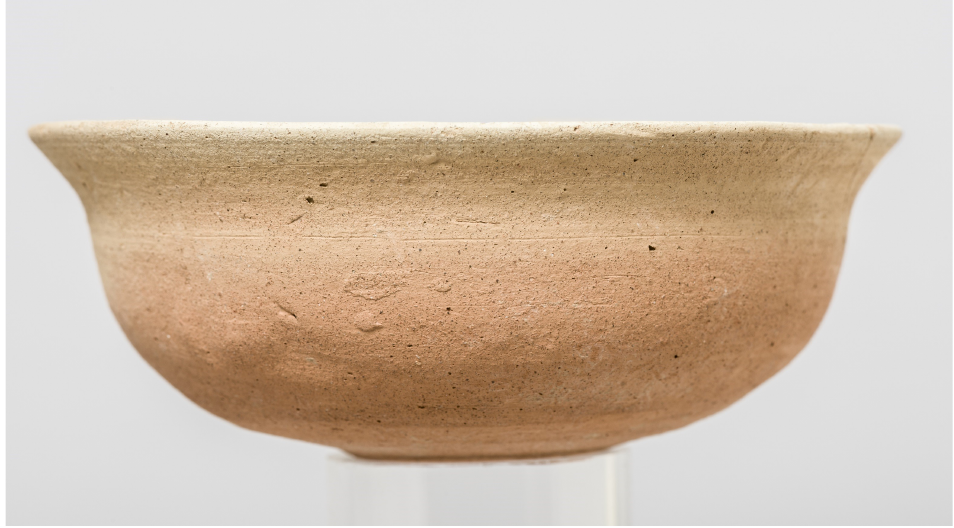
Figure 19. Plain White IV shallow bowl A.I.S. 0368.001, H. 4.7 cm, © Medelhavsmuseet.